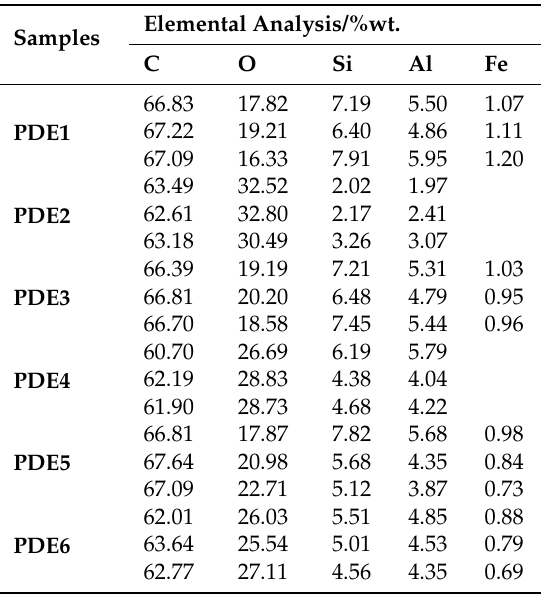
Table S1. EDX analysis of PDEs (1 to 6) fabricated using different batches (boxes 1–6) of HB pencils.